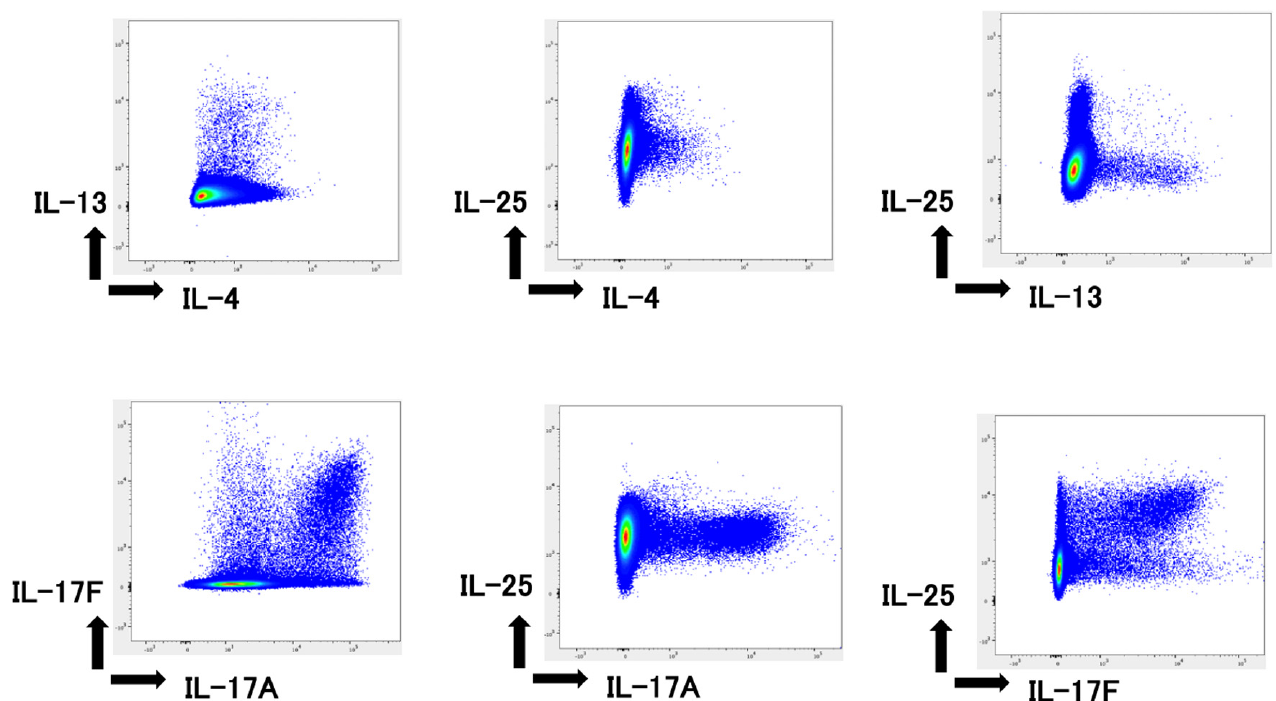
Figure 5. IL-25 production by type 2 and type 3 cells. The plots represent the co-production of indicated type 2 and type 3 cytokines as observed by flow cytometry. Intracellular staining results for type 2 and type 3 show some overlap between IL-4- and IL-13-producing cells. However, IL-25-producing cells also proved to be distinct from IL-4- and IL-13-producing cells. As for type 3 cytokines, IL-25 might be simultaneously produced by IL-17F-producing cells and not by IL-17A-producing cells.